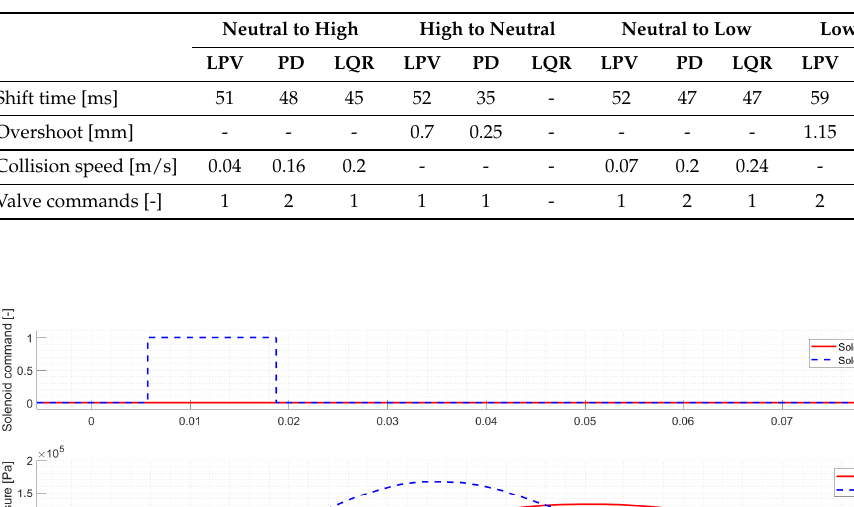
Table 3. Comparison of LPV, PD and LQR controllers